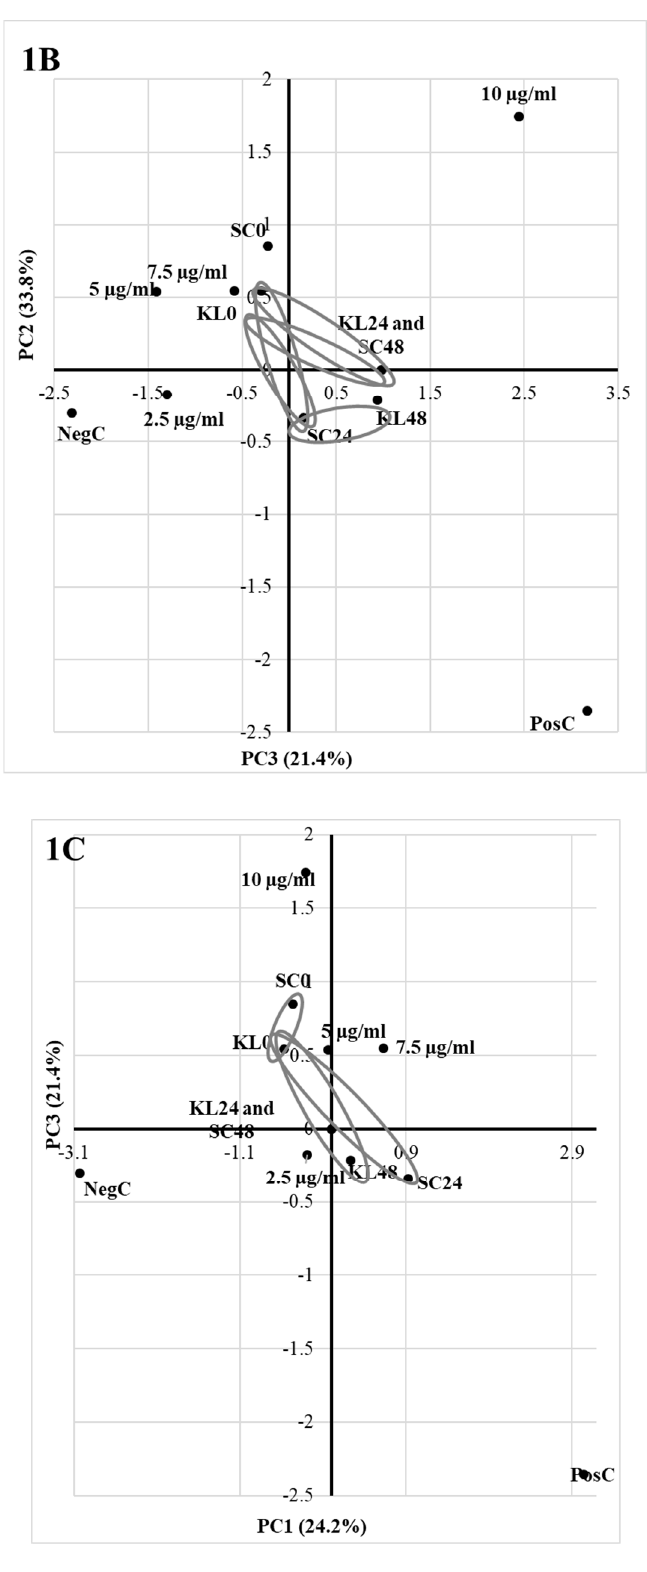
Figure 1. The PCA analysis of ammonia released at different times and initial acrylamide concentra- tions (scores) under various yeast strains– Saccharomyces cerevisiae DSM 70,478 and Kluyveromyces lactis var. lactis DSM 70,799 (loadings) for the first three components (A, B and C); circles indicate correlated loads and scores. Cneg, negative control; Cpos, positive control; KL0 and SC0, ammonia concentration at time 0; KL24 and SC24, ammonia concentration at time 24 h; KL48 and SC48, ammonia concentration at time 48